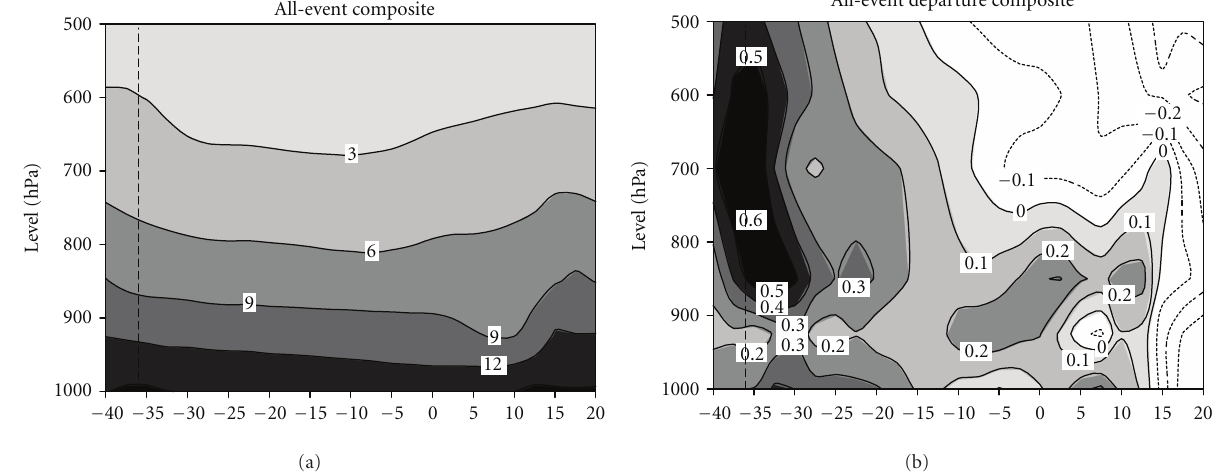
Figure 11: Same as Figure 8 but for the specific humidity (g · kg − 1 ). Positive values are shaded.